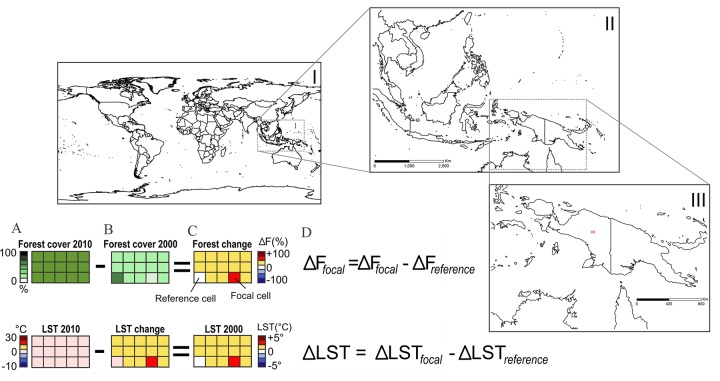
Methodological approach applied to quantify the relationship between forest change and local climate change.This approach was applied worldwide (I) to compare close cells sharing a similar regional climate (II and III). Each window had 15 cells of 0.05° resolution (5 longitude x 3 latitude cells). To facilitate visualization, a single window is depicted (red grid in III). In each window, data on local forest cover and local land surface temperature (LST) were compared by subtracting values in different years (2010–2000 for forest cover, 2011–2001 for climate; A and B), generating a georeferenced matrix of forest change and another of LST change (C). From the resulting matrices, two cells were chosen: a “focal” cell, with absolute forest change > 15%, and a “reference” cell, with forest change < 5%. Finally, we calculated the standardized forest change (ΔF) and the standardized LST change (ΔLST) (D), by subtracting the focal cell values by the reference cell values.